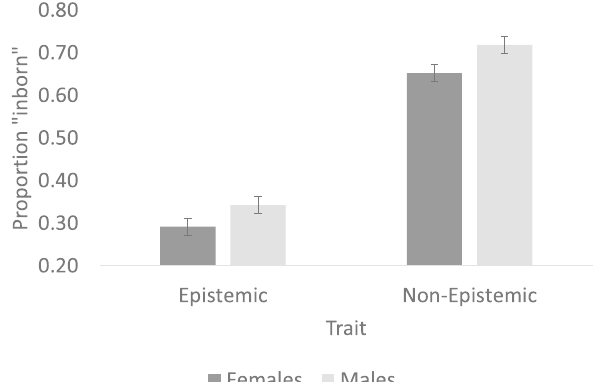
Figure 4. The perceived likelihood that psychological traits are inborn. Error bars are standard error of the means (computed over the subjects’ means).